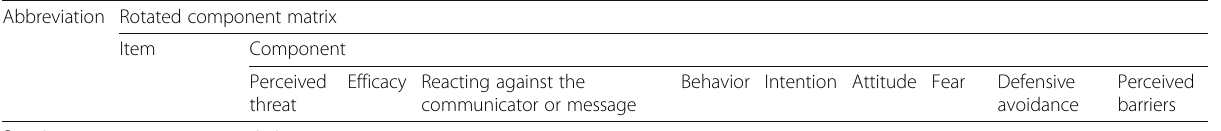
Table 1 Factor analysis and reliability results for discovery of main factors of questionnaire for evaluation of waste segregation beliefs and